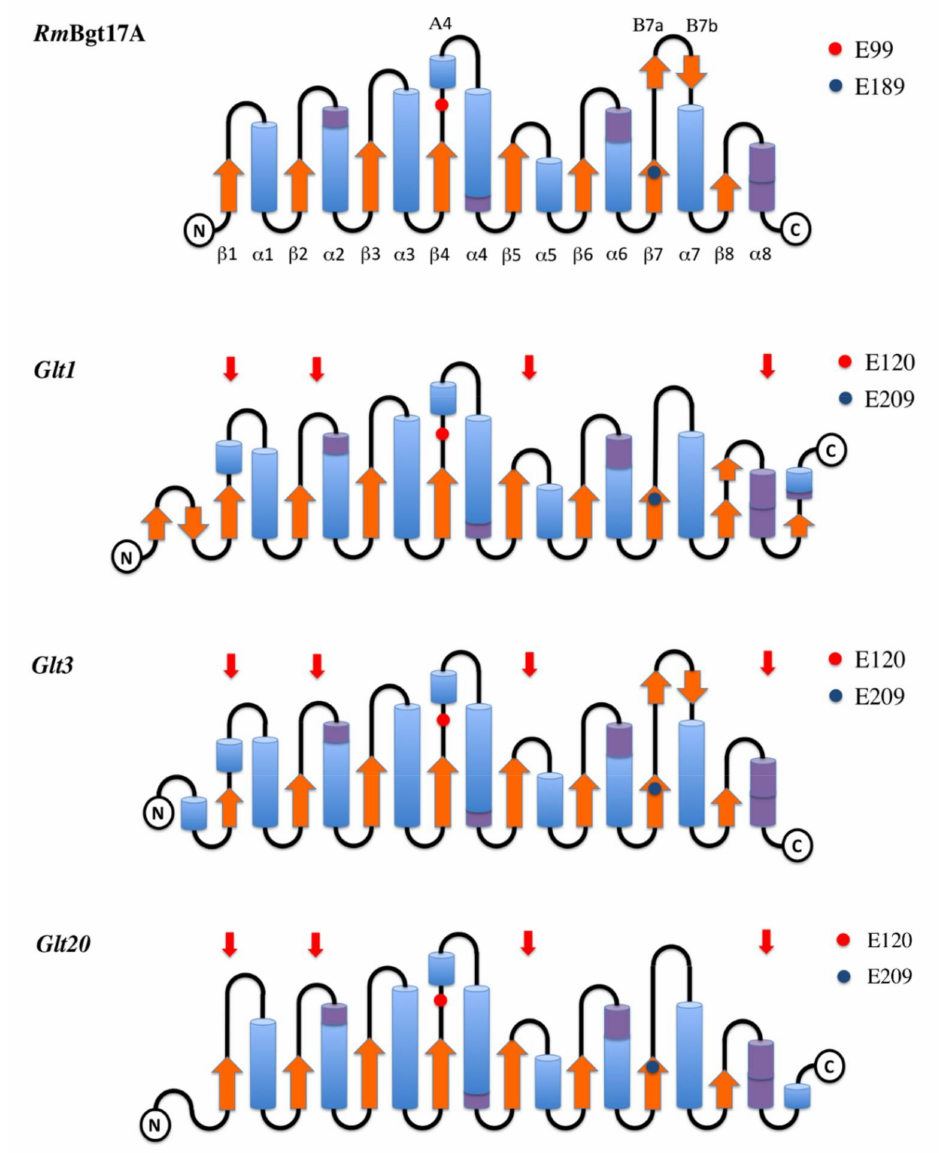
Figure 3. Schematic diagrams of super-secondary structures. The variations in loops associated with the catalytic cleft are indicated with red arrows. The potential proton donor amino acid is represented with a red spot between β 4 strand and the A4 alpha-helix, while the potential nucleophile is a blue spot in the end of the β 7 strand. Predicted β -strands are shown in orange, α -helices in light blue and 310-helices in darker